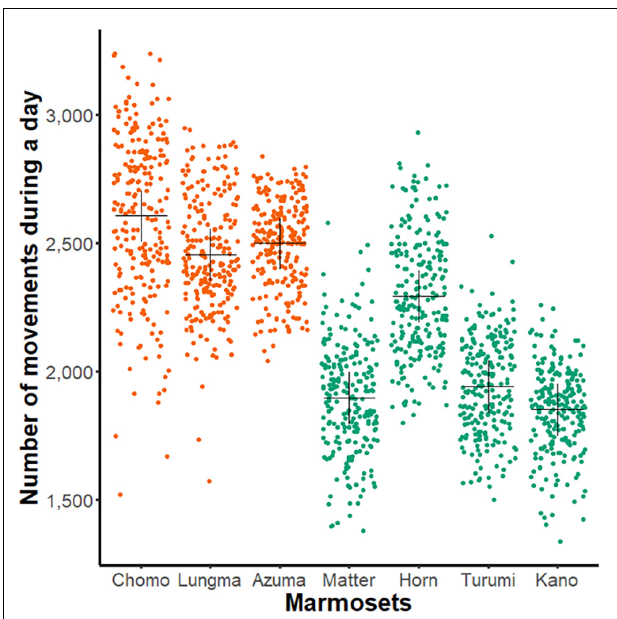
FIGURE 2 | Day-long activity of sub-adult and young-adult marmosets. A comparison of day-long activities (ordinate, aggregated number of movements, see Figure 1G ) of each marmoset (abscissa, n = 7, name of each marmoset is specified). Each dot represents the net activity for a single day. The black cross indicates mean for all measurement days for each animal; orange, sub-adult group and green, young-adult group.